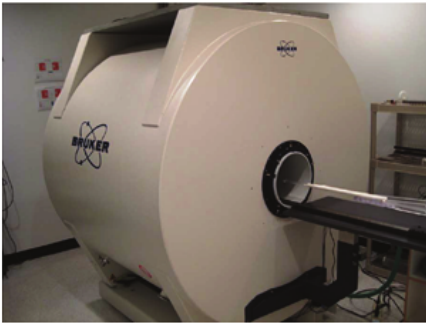
Figure 1: 7 T Bruker Avance